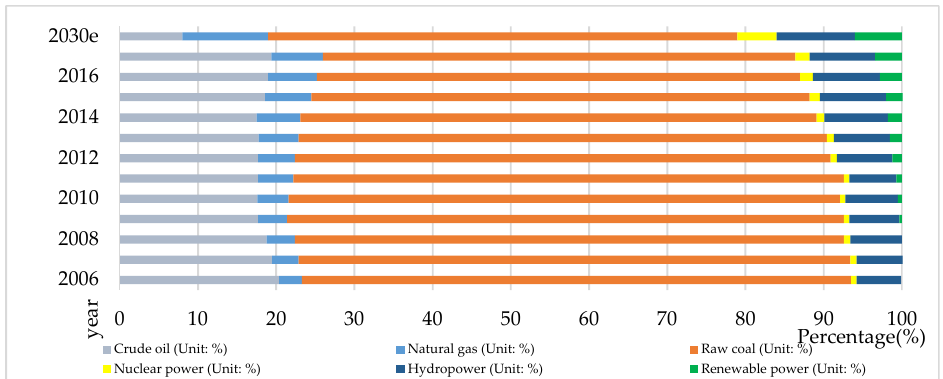
Figure 7. Energy structure during 2006–2017. Data source: BP Statistical Review of World Energy 2017 [58]; BP Statistical Review of World Energy 2018 [59]; Energy production and consumption reform strategy (2016–2030) [60]; Chinese industry information (2016) [61].